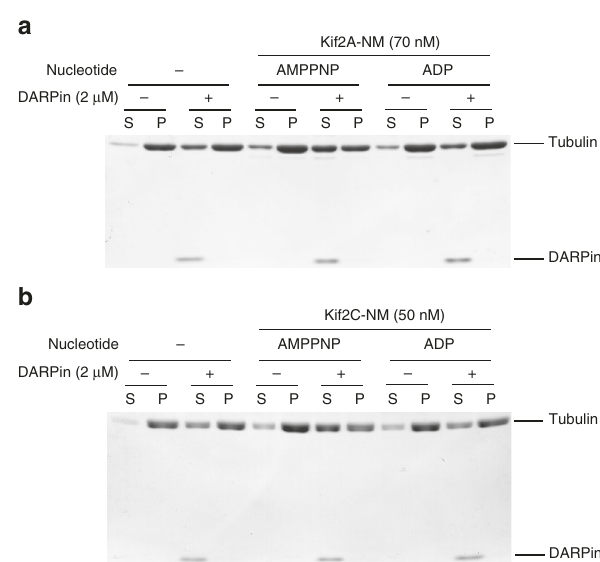
Fig. 7 Nucleotide-dependent effect of DARPin on MT depolymerization by kinesin-13. a , b Depolymerization of taxol-stabilized MTs by Kif2A-NM ( a ) or Kif2C-NM ( b ) in the absence or presence of 2 µ M DARPin and the indicated nucleotides (no nucleotide, AMPPNP, or ADP) was assessed by MT sedimentation assay. Samples were processed as described in Fig. 6f. A representative gel from at least three independent experiments is